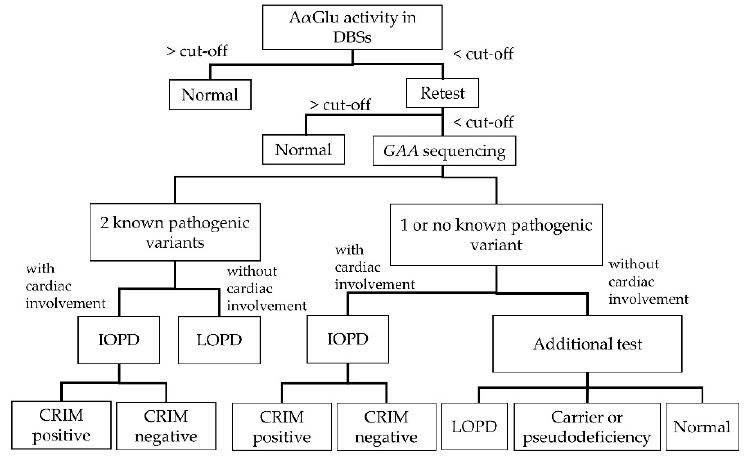
Figure 2. Flow chart of diagnosis for PD (modified from the Pompe Disease Newborn Screening Working Group [8]). DBS: dried blood spot; CRIM: cross-reactive immunological material.